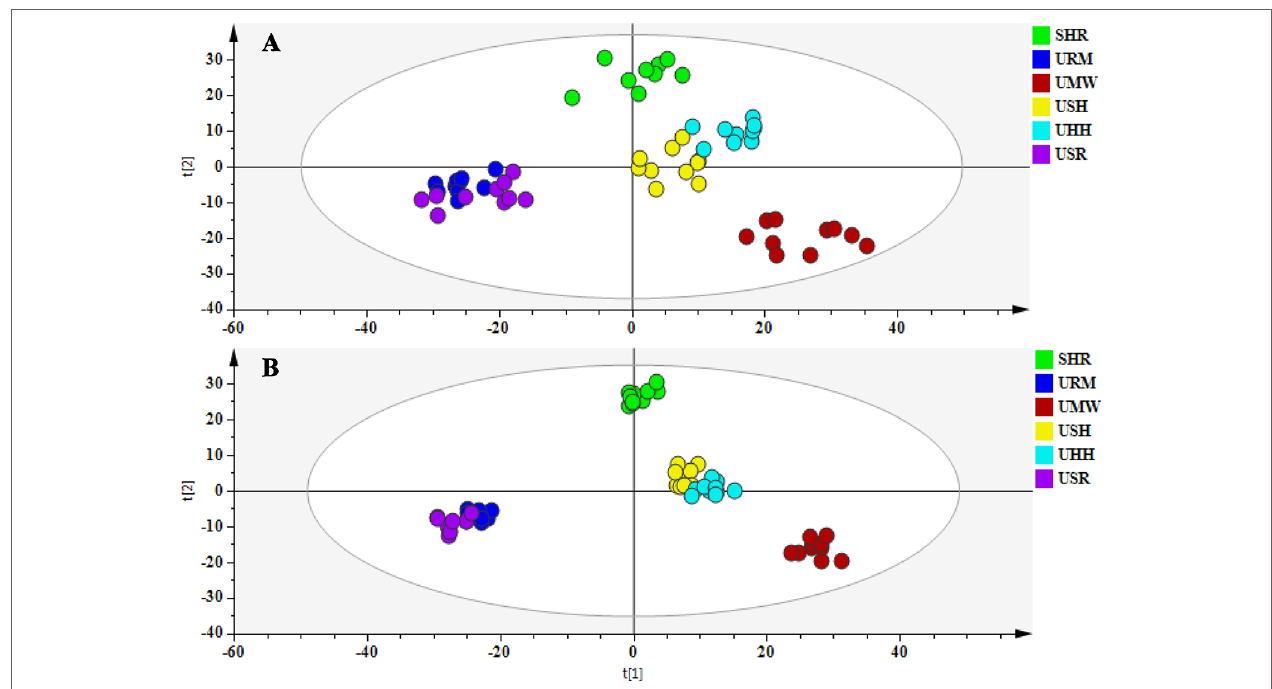
FIGURE 5 | O2PLS-DA score plots of urine metabolic profiling of the SHR and treatment groups in the positive mode (A) and the negative mode (B) .